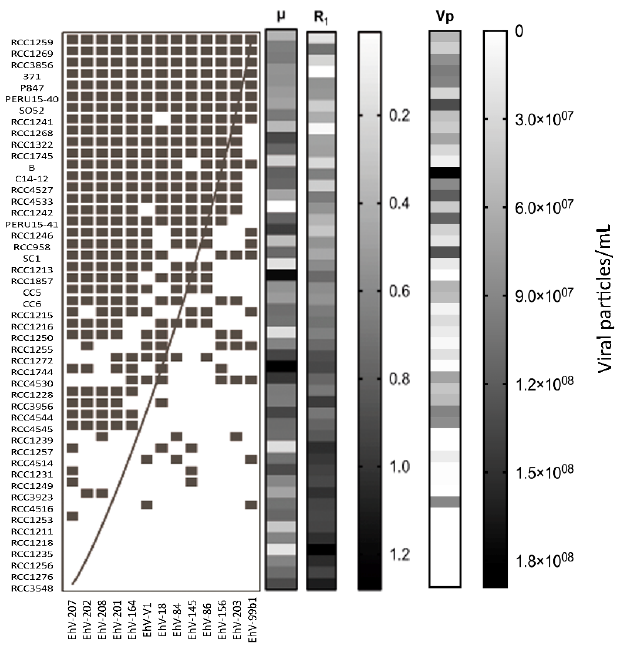
Figure 6. Viral ‐ host infectivity network with a clear nested pattern (NODF value of 0.60) where specialist viruses tend to infect the most susceptible hosts, while viruses with broader host ‐ range infect hosts with higher resistance. (cid:4) : infection; (cid:3) : no infection. Sidebars represent µ , R 1 and Vp parameters, respectively.